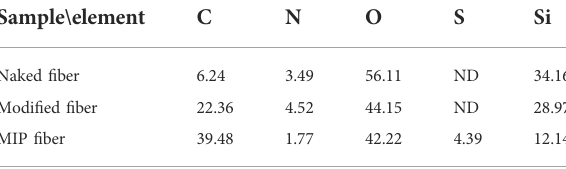
TABLE 2 Elementary analysis results of different